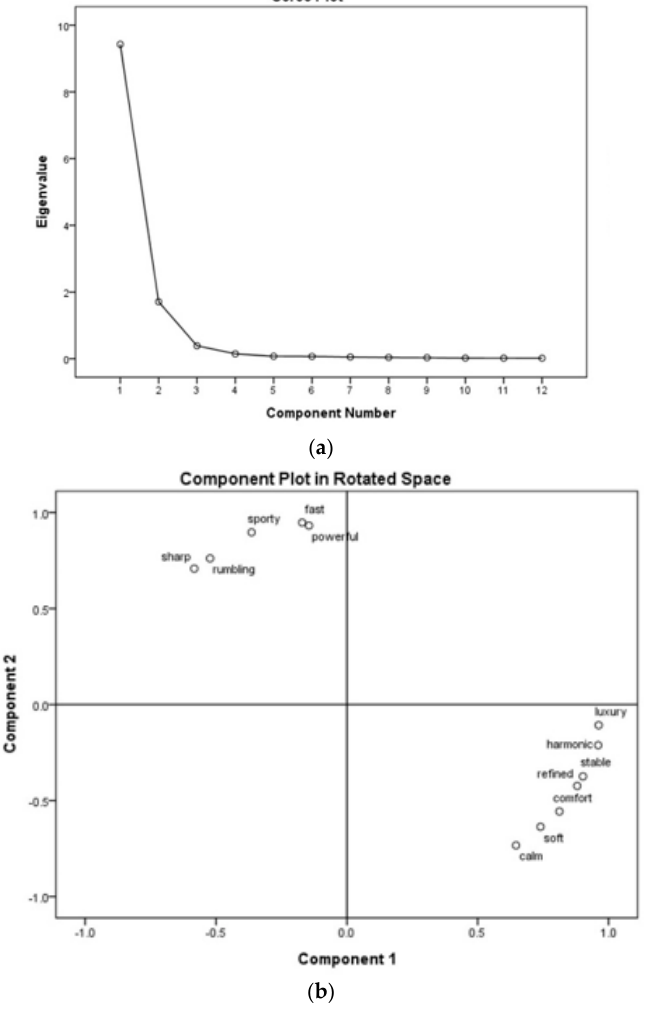
Figure 3. Results of scree plots (a) and principal component analysis (b) for automobile acceleration sound. Table 3. Results of factor analysis for extracting representative affective dimensions in engine